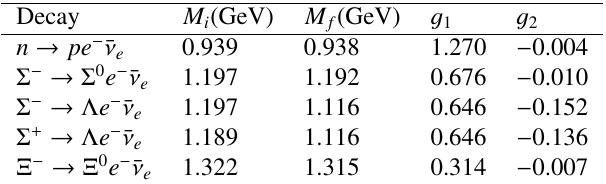
Table 3. The decay constants g 1 ( Q 2 = 0) and g 2 ( Q 2 = 0) for the strangeness conserving